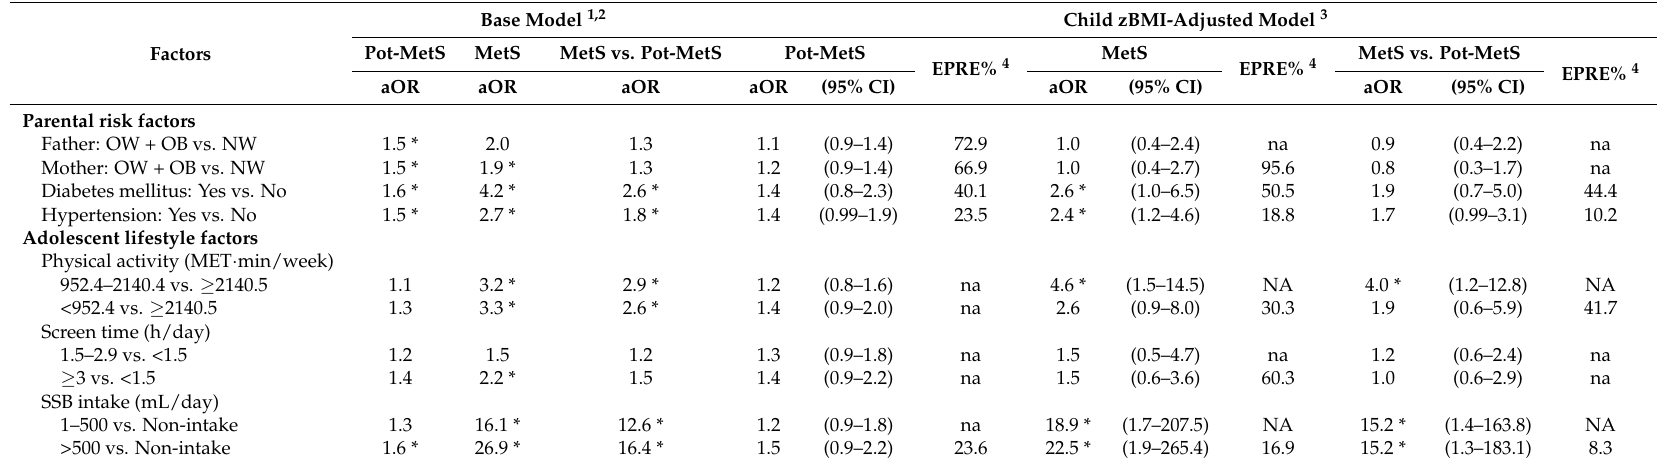
Table 4. Excess prevalence ratios of adolescent potential metabolic syndrome and metabolic syndrome explained by adolescent body mass index for significant parental and adolescent’s risk